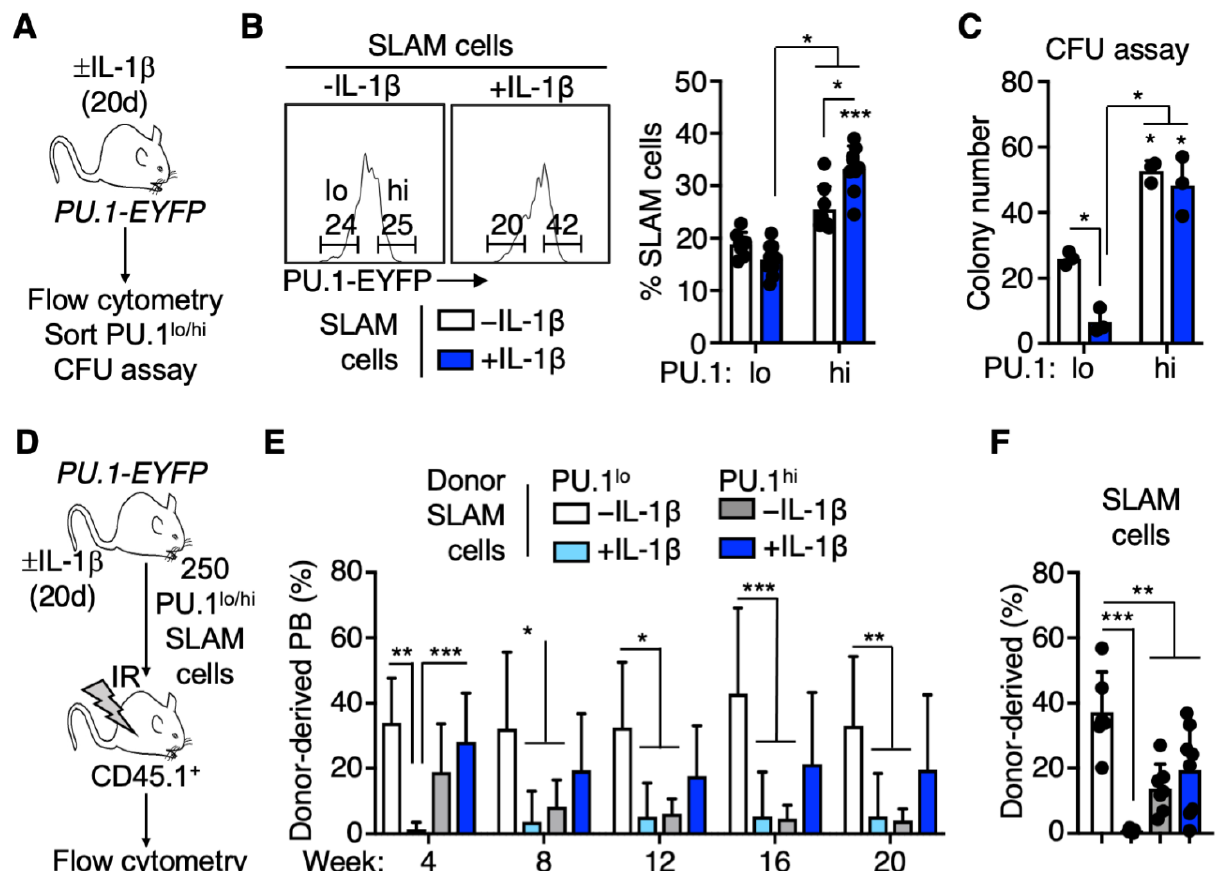
Figure 1. PU.1 levels define distinct repopulating activities following chronic IL-1 β treatment. ( A ) Experimental design for isolation and functional characterization of PU.1 hi/lo SLAM fractions of PU.1-EYFP mice treated for 20 d IL-1 β . ( B ) Representative FACS plot (left) and summary data (right) showing frequency of PU.1 lo and PU.1 hi SLAM cells in PU.1-EYFP mice treated for 20 d IL-1 β ( n = 6–8/grp). Individual values are shown, and bars represent mean values. Data are compiled from two independent experiments. ( C ) CFU assay of PU.1 lo and PU.1 hi SLAM cells isolated from PU.1-EYFP mice treated for 20 d IL-1 β ( n = 3/grp). Individual values are shown, and bars represent mean values. Data are representative of two independent experiments. ( D ) Experimental design for isolation and transplant of purified PU.1 hi and PU.1 lo SLAM cells from PU.1-EYFP mice treated for 20 d IL-1 β into lethally irradiated recipient mice. ( E ) Summary data showing donor peripheral blood chimerism in transplanted recipient mice ( n = 6–8/grp). Data are compiled from two independent experiments. Bars represent mean values. ( F ) Summary data showing donor BM SLAM cell chimerism in recipient mice at 20 weeks post transplant ( n = 6–8/grp). Individual values are shown, and bars represent mean values. Data are compiled from two independent experiments. Data are shown as means SD. Significance was determined by ANOVA with Tukey’s post-test. * p < 0.05; ** p < 0.01; *** p <